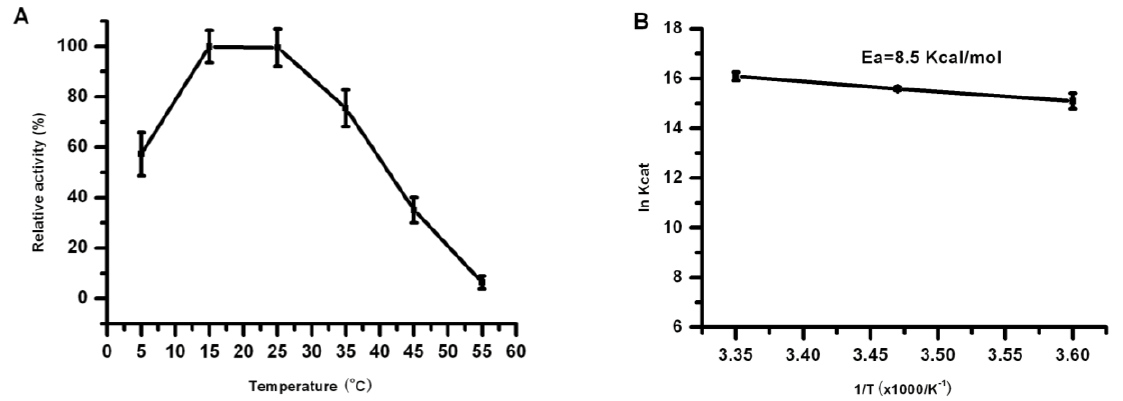
Figure 4. Effects of temperature on Lip5-DM activity: ( A ) The purified Lip5-DM was assayed at different temperatures. Activities are displayed as percentages of the maximum activity (31.27 U/mg). Values are means ± SD from three independent experiments; ( B ) To determine the activation energy, the logarithm of the K values was plotted against the cat reciprocal of absolute temperature ( T ). The values shown are activation energy calculated from the Arrhenius plot.